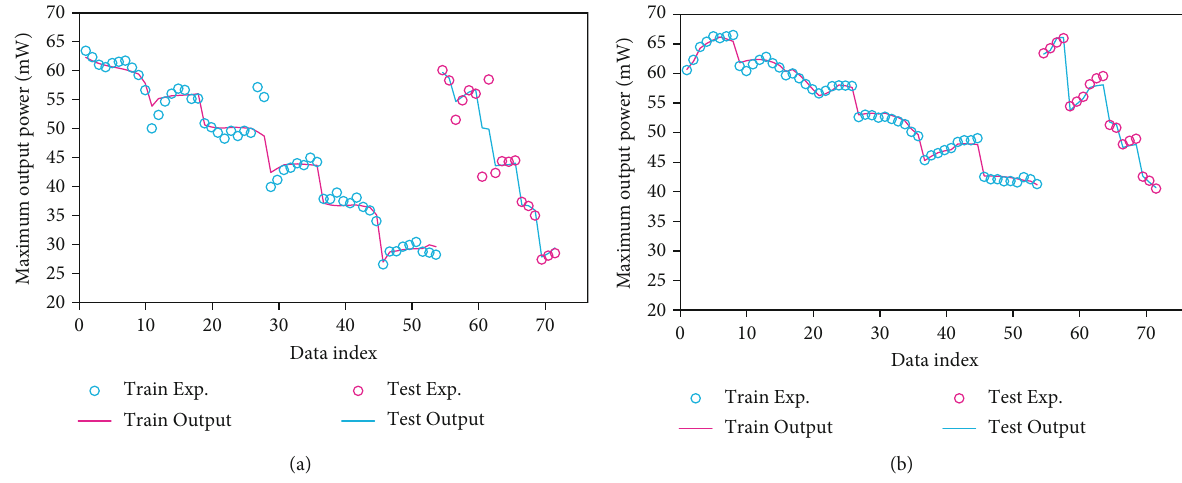
Figure 3: The predicted maximum output power by ANFIS for (a) monocells and (b)